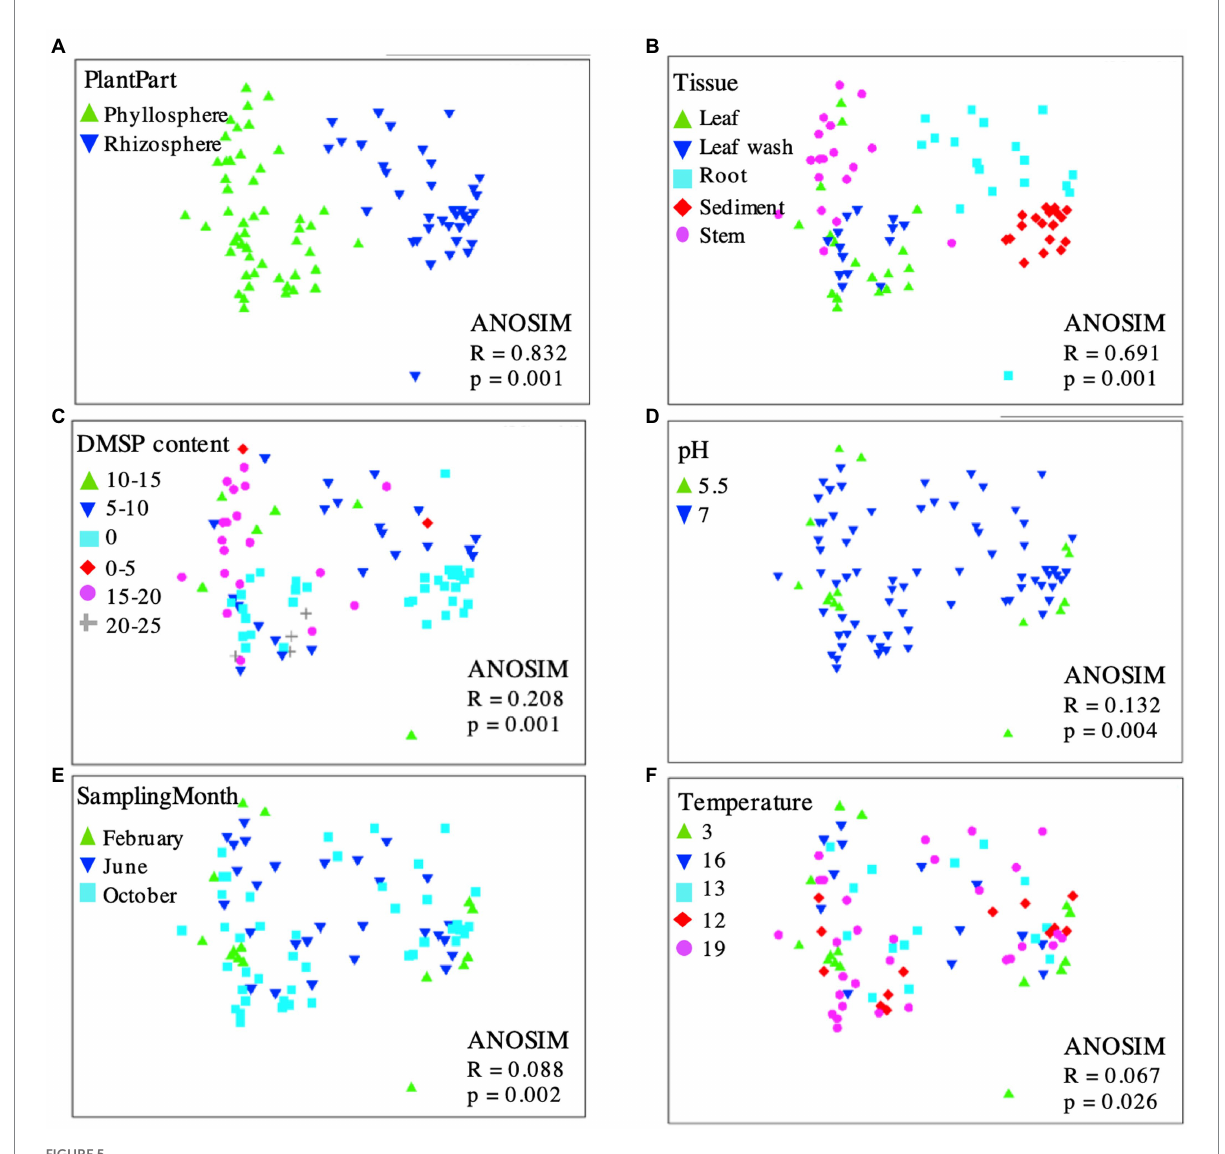
FIGURE 5 Multidimensional scaling (MDS) plot displaying 16S rRNA gene-based bacterial community composition at bacterial genus level of leaf wash, leaf, stem, root and sediment samples with superimposed codes representing plant part (A) , tissue sample (B) , DMSP content (C) , pH (D) , sampling month (E) , or temperature (F) . Proximity of points reflects similarity. OTUs diversity among phyllosphere and rhizosphere samples is highly similar, indicating bacterial communities are independent of DMSP content, pH, sampling month and temperature but not tissue or plant part. MDS ordinates and ANOSIM (analysis of similarity) were determined by calculating a dissimilarity matrix (Bray-Curtis) based on the OTUs. Calculations, MDS, and ANOSIM were done using PRIMER